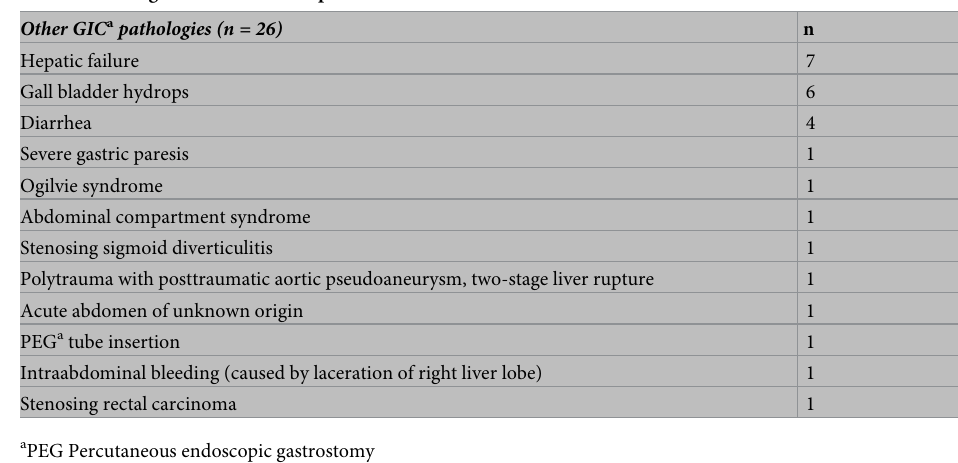
Table 2. Other gastrointestinal complications in